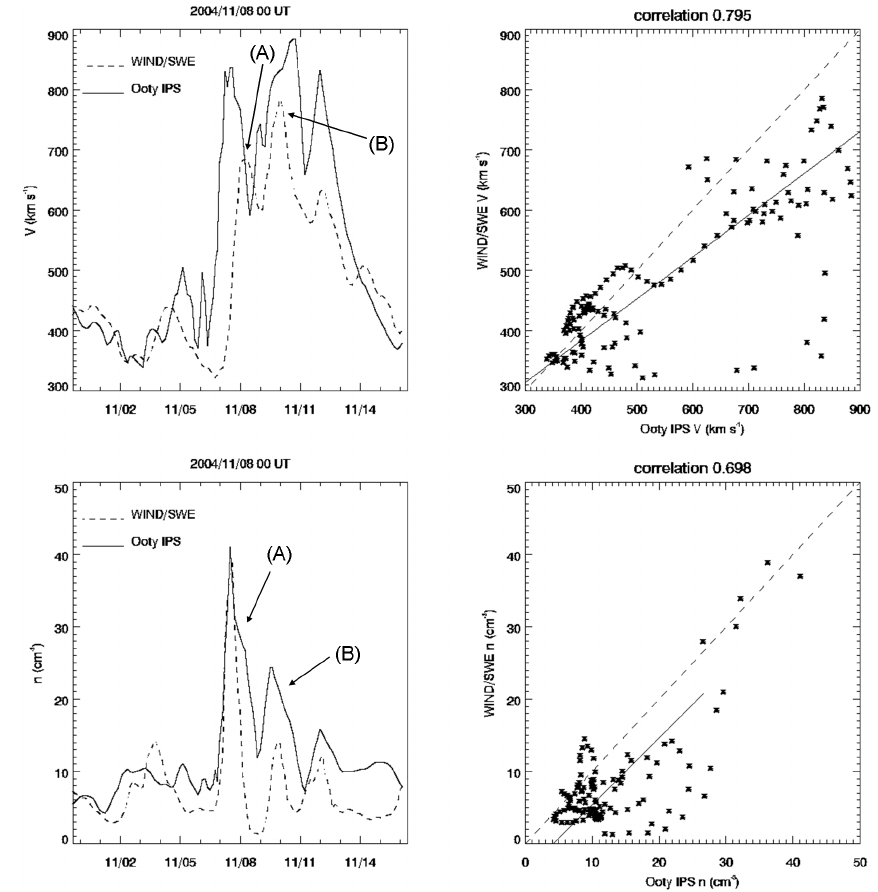
Fig. 2. The top-left plot compares the velocity time series at the Wind spacecraft extracted from the Ooty IPS reconstruction (solid line) with Wind solar wind velocity measurements (dashed line), and similarly the bottom-left plot for Wind density measurements. Both the Wind spacecraft velocity and density data are hourly-averaged data that were further averaged with a half-daily cadence to match that of the 3-D reconstruction cadence. The top-right plot shows the correlation of the two data sets for velocity, and similarly the bottom-right plot for density; the dashed line on each correlation plot is for a 100% correlation while the solid line shows the best-fit of the data here. (A) and (B) on the left-hand plots relate to features also highlighted later in Fig. 3 and Fig. 4, with the description of each to be found in the